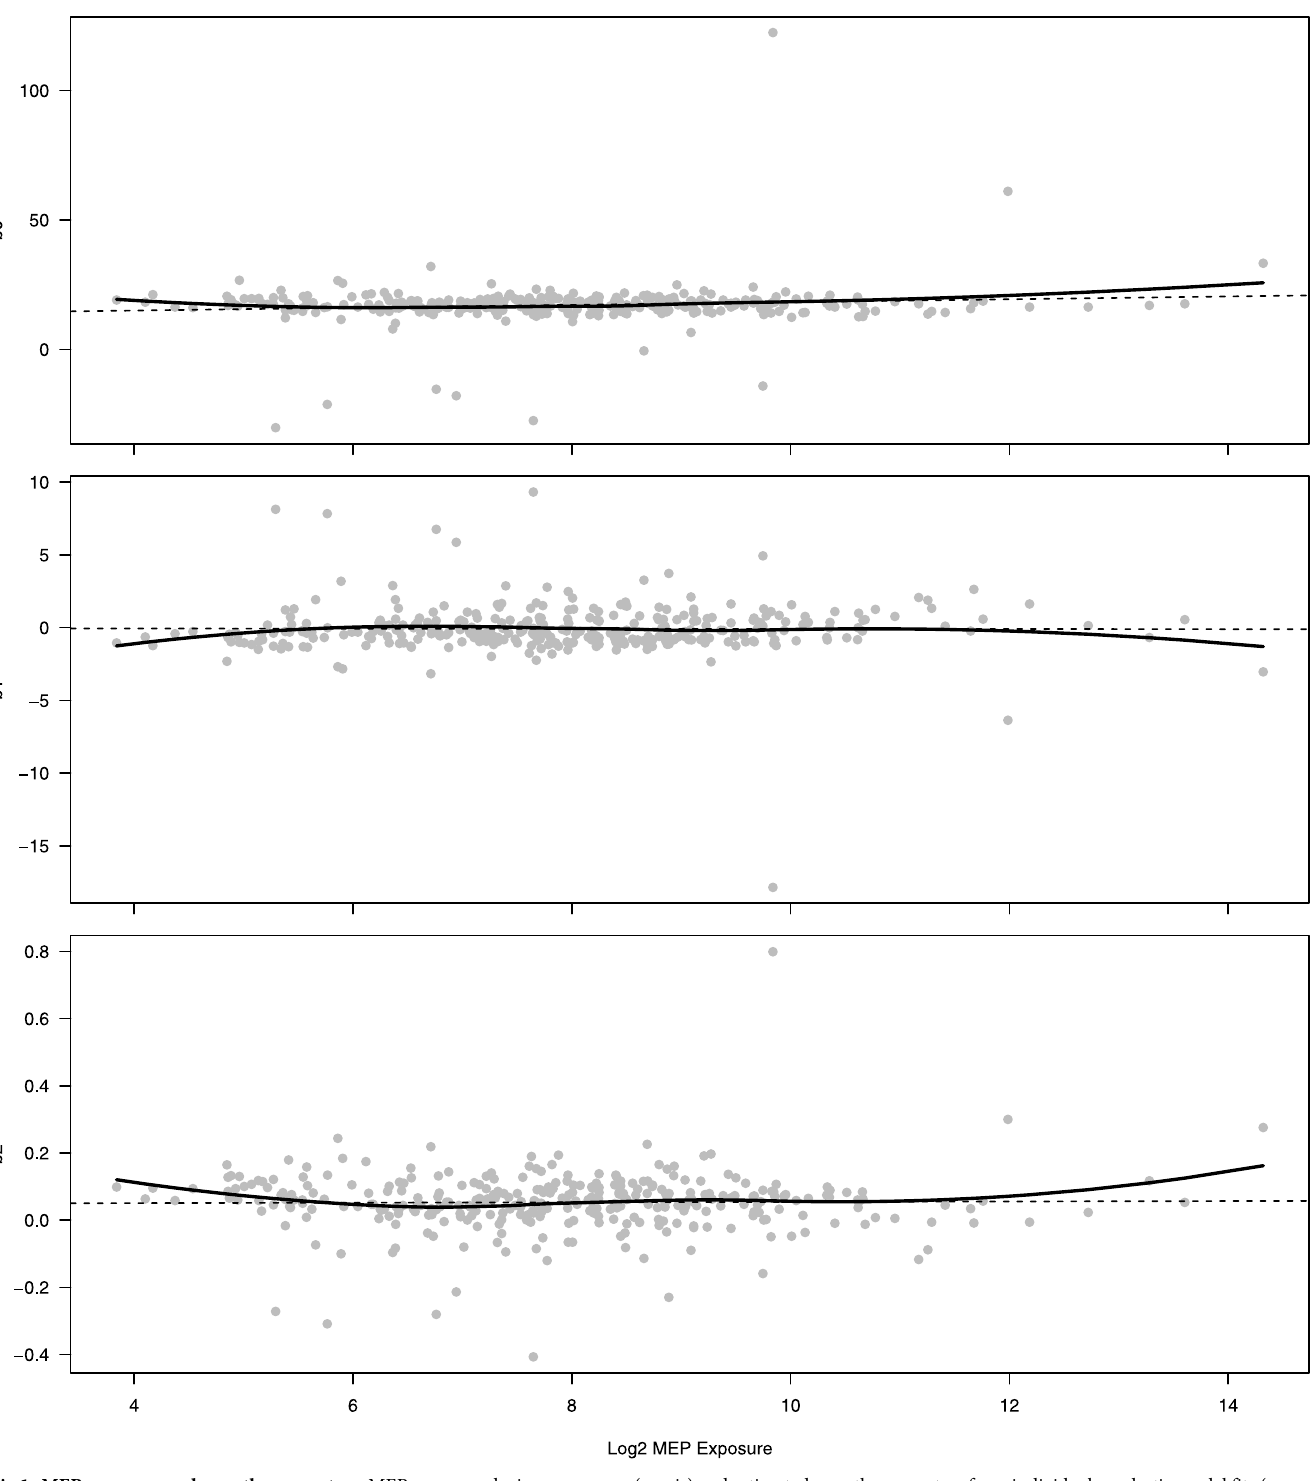
PLOS ONE | https://doi.org/10.1371/journal.pone.0209321 December17,